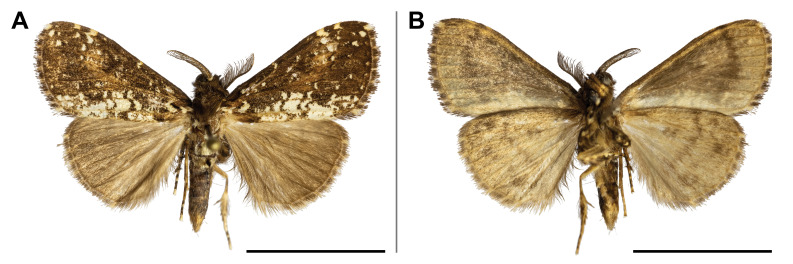
Dasychira
punctifera (Walker, 1858). A. dorsal view; B. ventral view. The scale bar represents 1 cm.